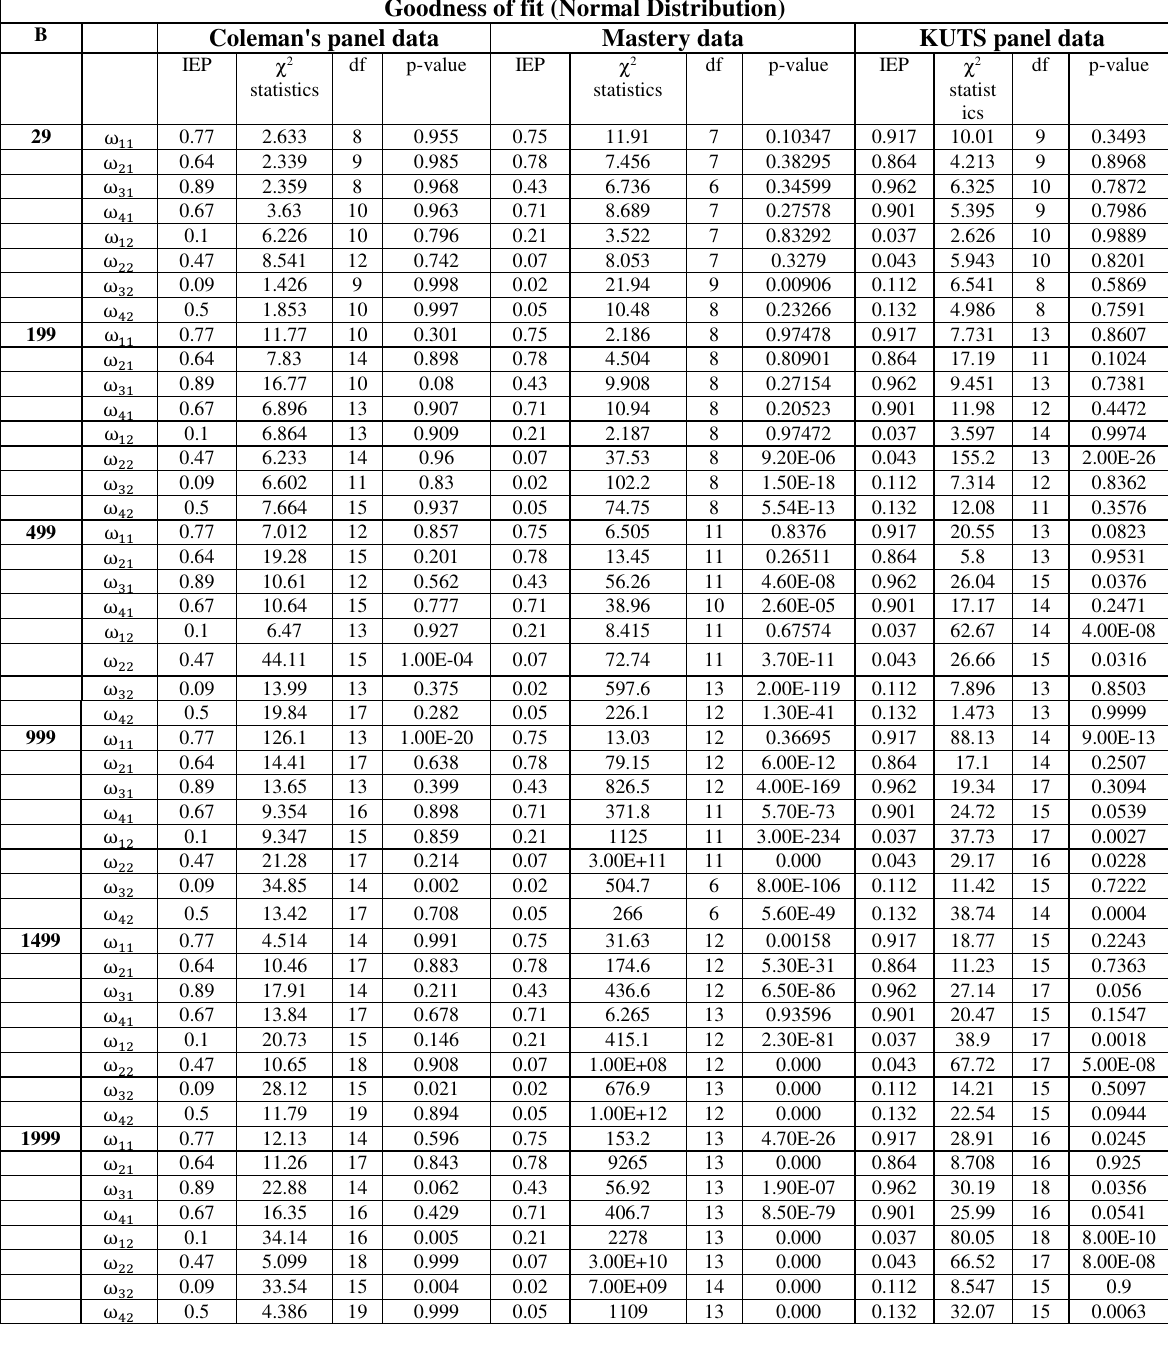
TABLE 4: A SUMMARY TABLE OF CHI-SQUARE TEST FOR ASSESSING NORMAL DISTRIBUTION TO BE GOOD FITTED ON THE HYPOTHESIZED (BOOTSTRAP SAMPLES) BASED ON IRP’S OF A 2-CLASS LM FOR COLEMAN’S PANEL, MASTERY AND KUTS PANEL DATA. Goodness of fit (Normal